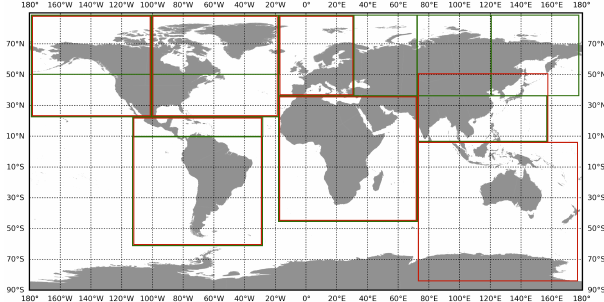
Figure 1. Source regions for the tagged CO simulation. Regions outlined in red denote fossil fuel tagged tracers; regions outlined in green refer to biomass burning tagged tracers.